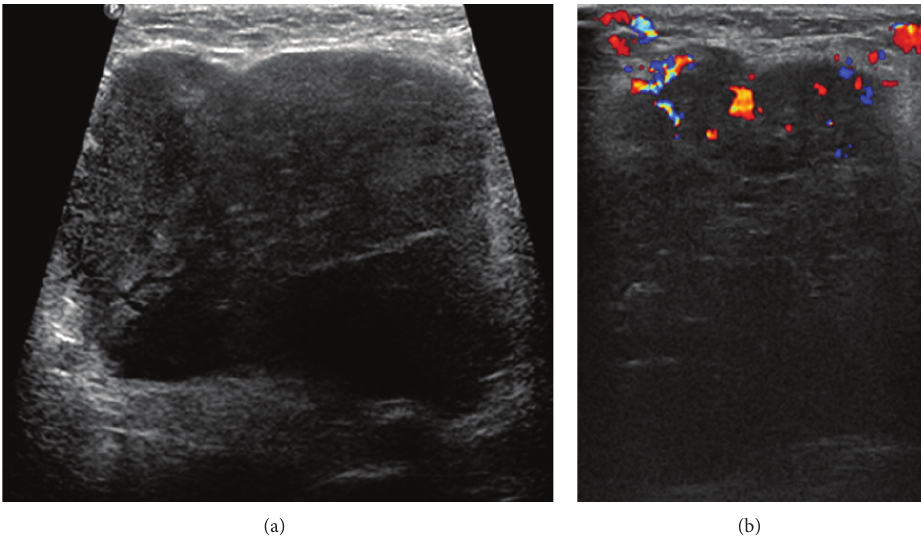
Figure 1: Transverse (a) and color Doppler (b) images of ultrasonography show an irregular mass with an indistinct margin, internal hypoechogenicity, and increased peripheral vascularity.